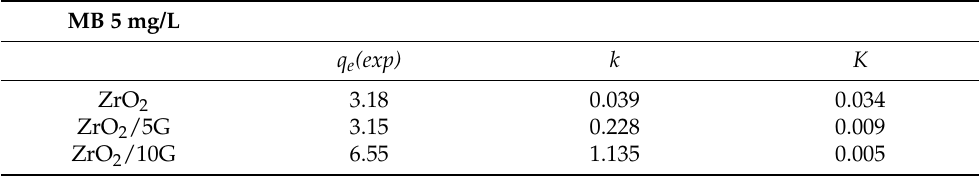
Table 3. First-order reaction rate constants ( k ) and the degradation equilibrium constant ( K ), and experimental q e values for the 5 mg/L MB degradation on ZrO 2 , ZrO 2 /5G, and ZrO 2 /10G at 303 K. MB 5 mg/L